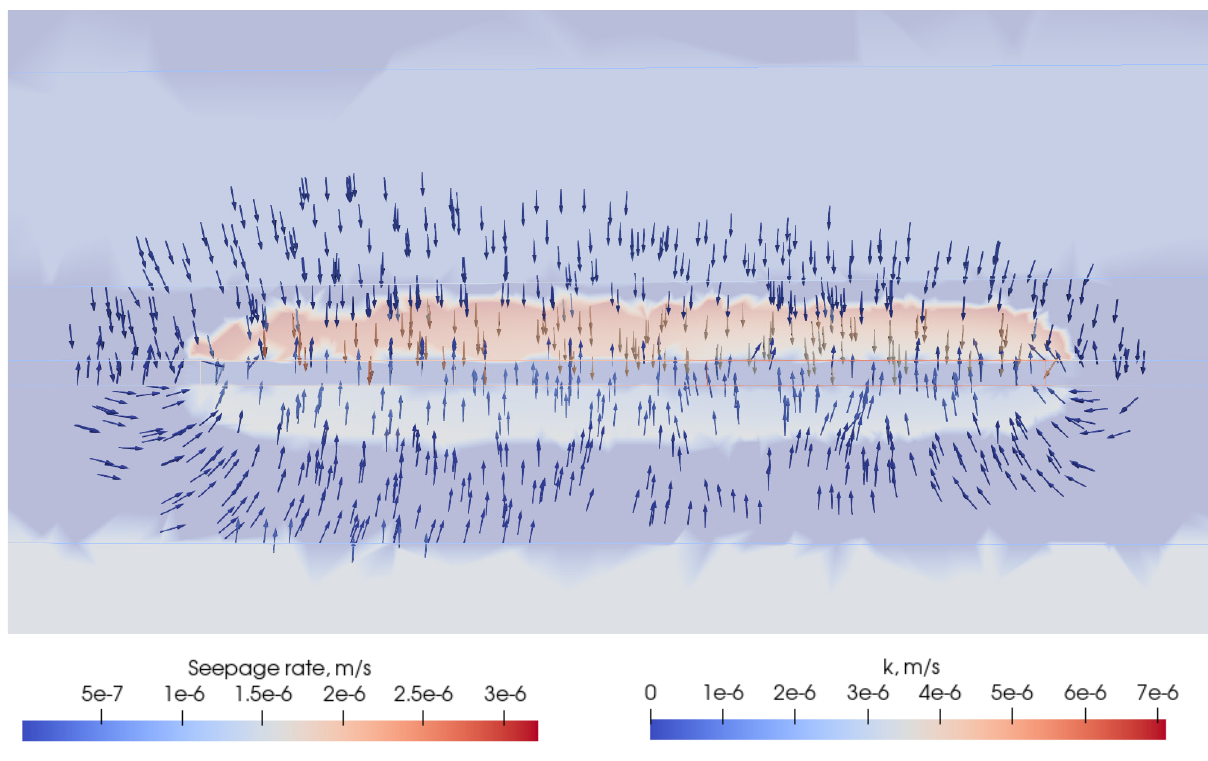
Figure 13: Vector field of water conduction rate (m/s) on the background of the permeability (m/s) in cross-section y = 750 m at t = 1.5 year.